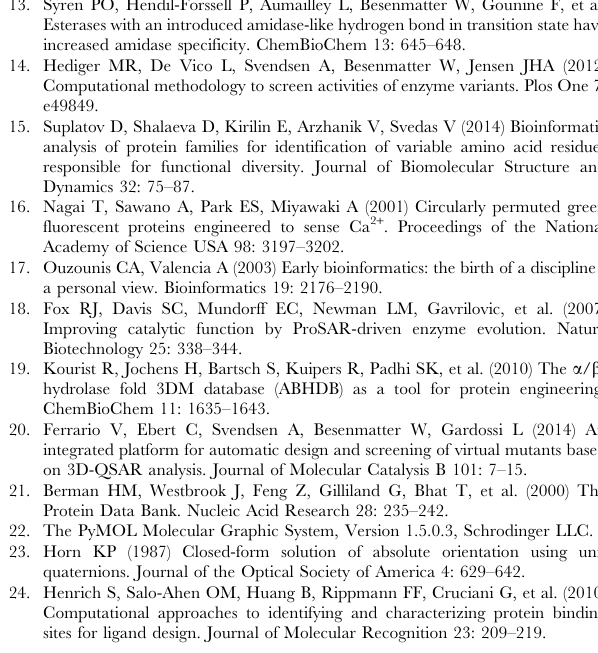
Figure S1 Quadruplets definition according to BioGPS algo- rithm; each quadruplet is defined as a bitstring as indicated at the bottom of the picture. (TIF) Figure S2 Dataset clustering based on RMSD multidimensional scaling. Each structure is projected according to RMSD structure similarity (referred to the same structure and to all the other enzymes). The RMSD was calculated by superposing the backbone atoms of each enzyme structure. Table S1 Ser hydrolases analyzed, for each crystal structure the residues used for the catalytic machinery based superimposition are